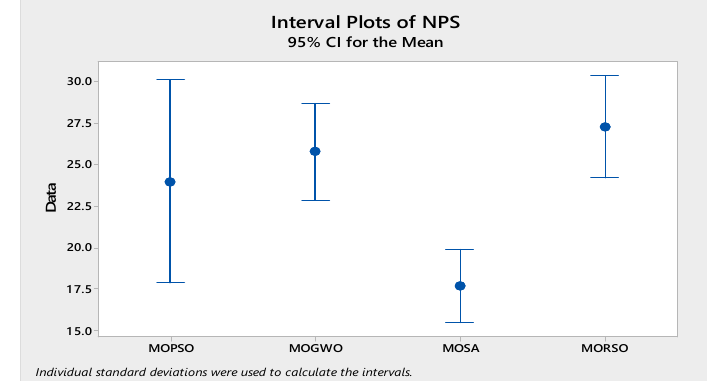
Individual standard deviations were used to calculate the intervals. Figure 18. Interval plots of NPS.